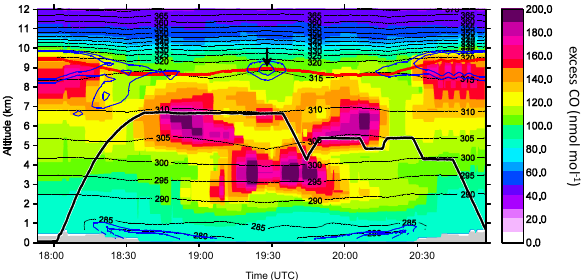
Fig. 7. FLEXPART calculations of excess CO passive tracer con- centration in nmolmol − 1 along the flight track (thick black line). The thin black lines indicate potential temperature in K, the thick red line denotes the 2 PVU isosurface, the thin blue contours show 80 and 90% relative humidity. The arrow indicates the turning